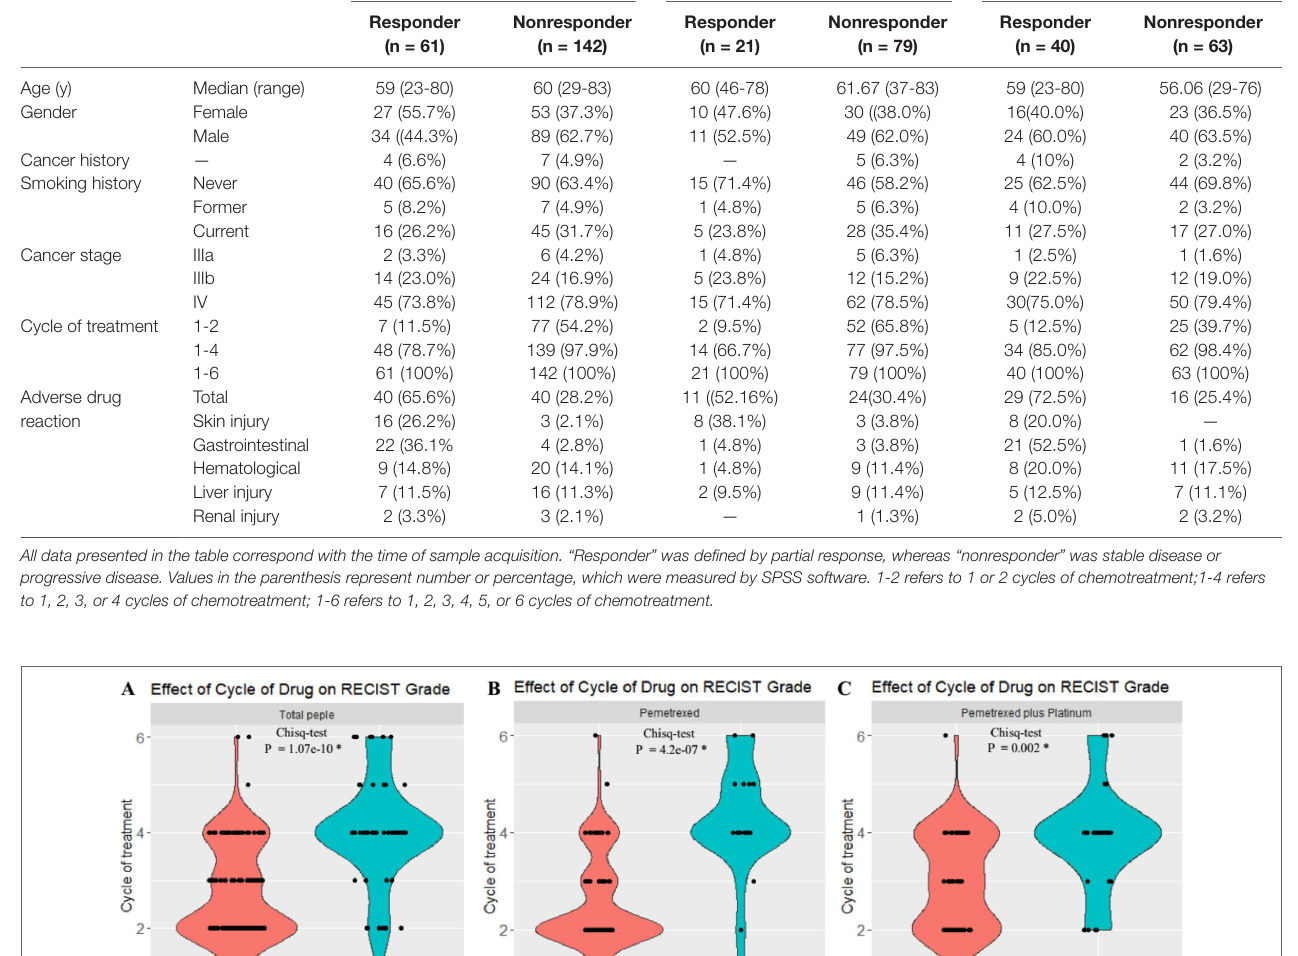
TABLE 1 | Study subject demographics and clinical status. Characteristics All patients